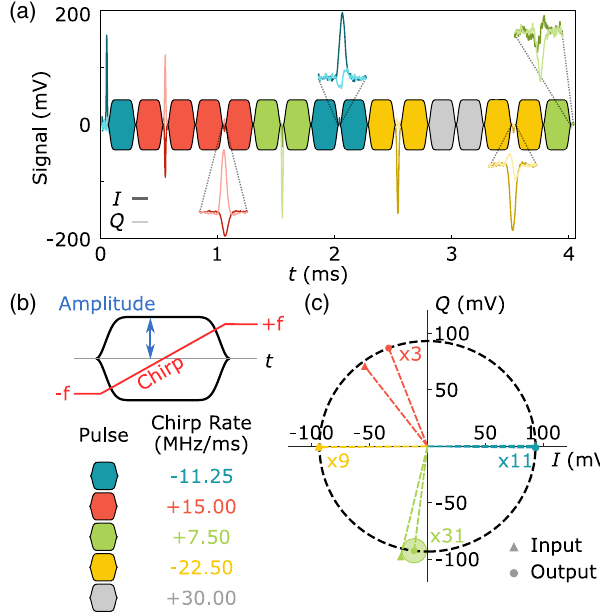
FIG. 5. Experimental demonstration of the random-access memory protocol. (a) An illustrative segment of the protocol in which WURST pulses, excitations, and echoes are color coded, with WURST parameters as defined in (b). In total four excitations are stored for times up to 2 ms. Excitations and echoes are shown with magnified echoes offset from the main trace. The first and last pulses do not come in pairs as the memory sequence starts and finishes halfway through a clock cycle. (c) Echoes and excitations on an Argand diagram matching their phases. The magnitude of each echo is rescaled to account for losses from the finite spin-resonator cooperativity in this experi- ment and spin